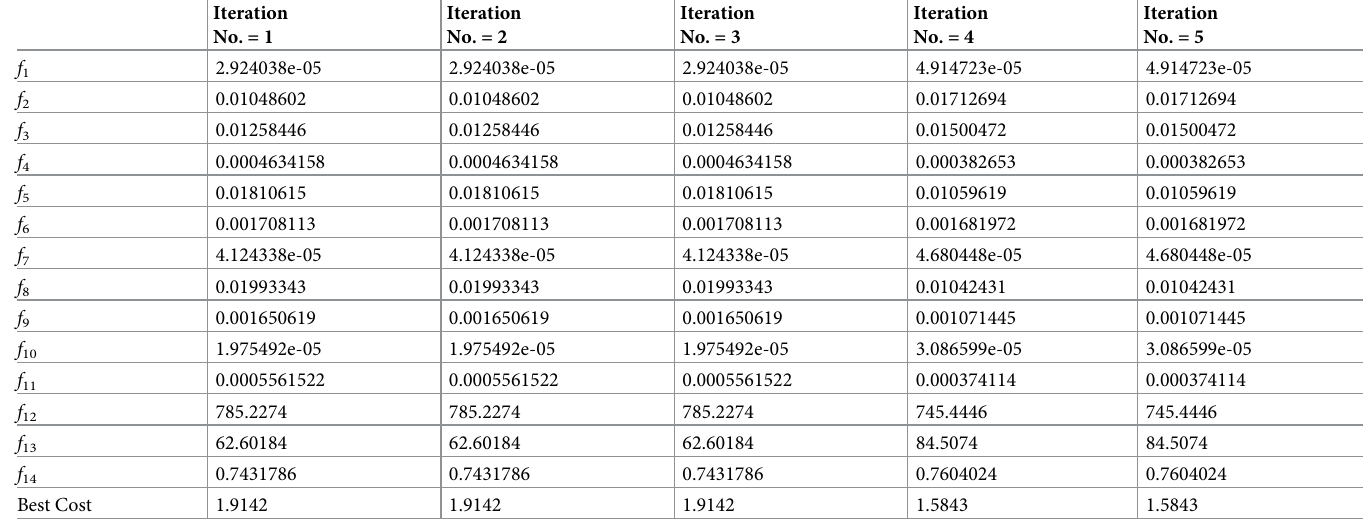
Table 1. The results when using PSO